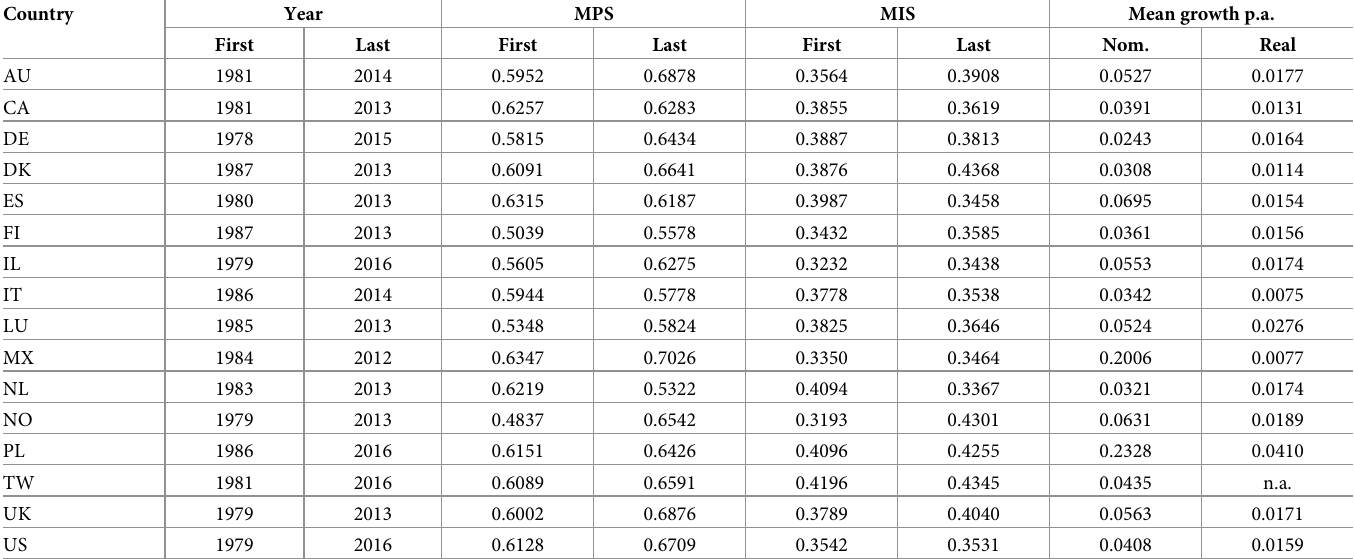
Table 4. Summary statistics of the data set.